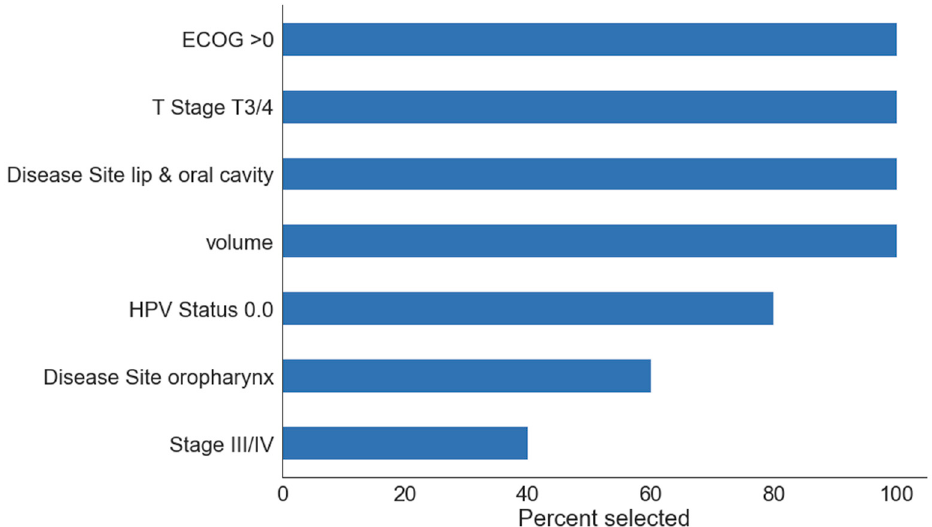
Figure 2. Feature importance in the multivariate clinical model. The importance score is computed as the percentage of cross-validation folds where the feature was selected in the model, so that a score of 100% indicates that the feature was selected in every fold. For clarity, only features that were selected at least once are shown. Volume—GTVp volume, HPV status 0.0—negative.